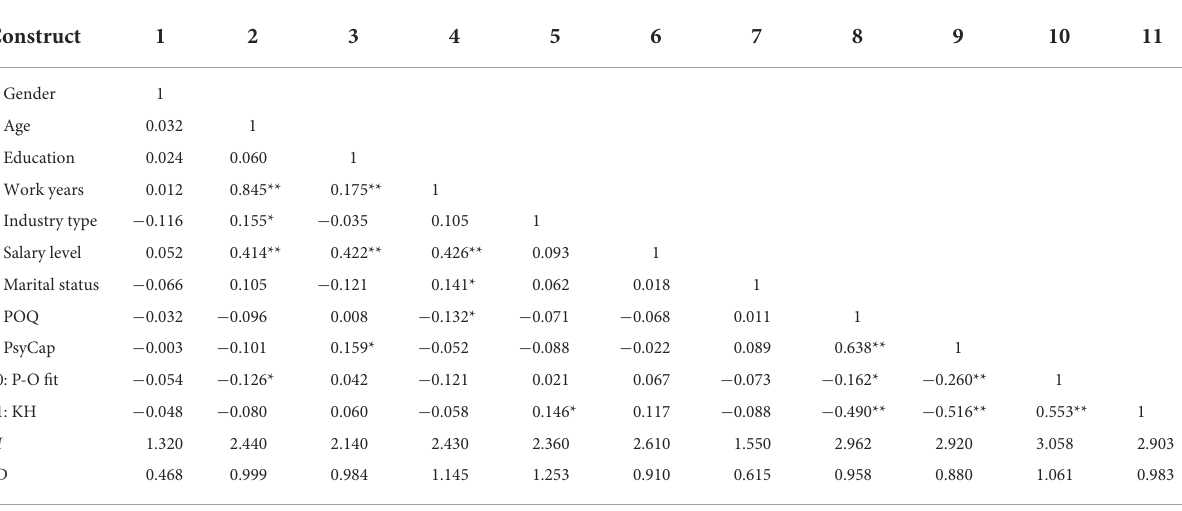
TABLE 4 Results of descriptive statistics